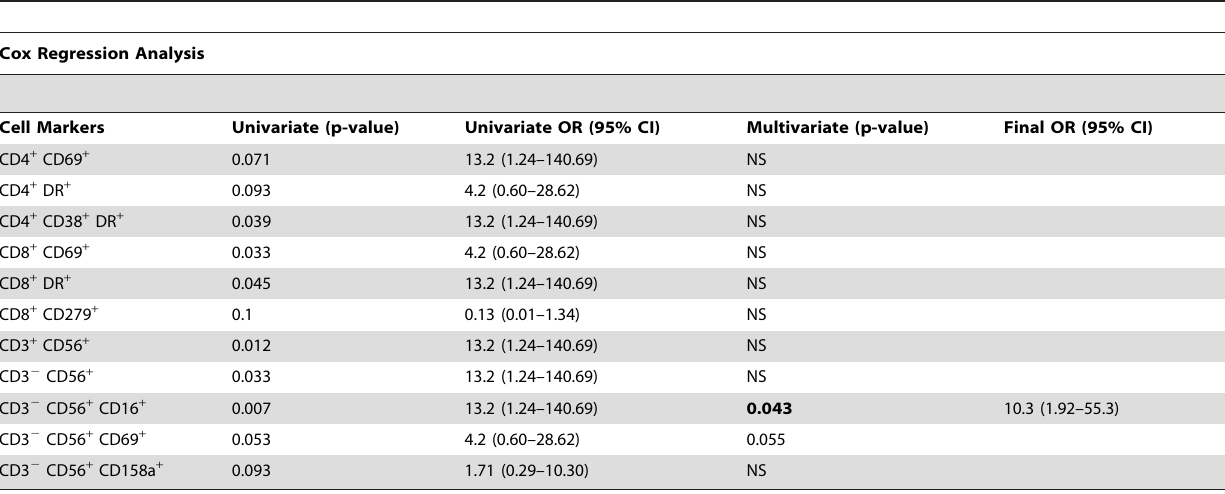
Table 2. Univariate and Multivariate Regression Analysis of Baseline T and NK Cell Populations and Immune Activation Markers and the Risk of Detectable Plasma HIV-1 RNA.